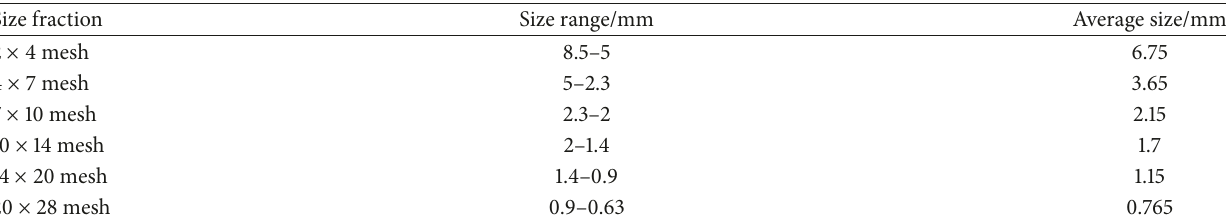
Table 2: The size range and average size of iron ore